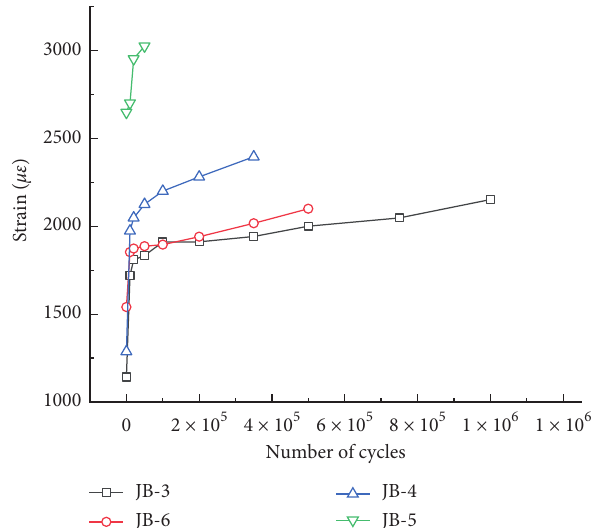
Figure 9: Strain values of compression zone concrete with cycle number.